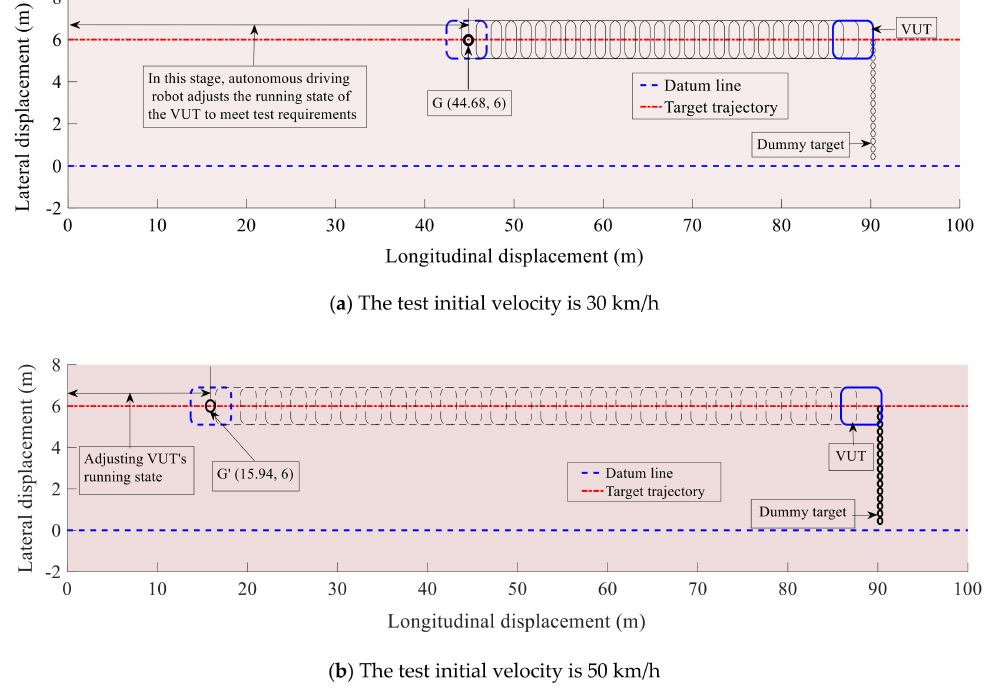
Figure 13. The demonstration process diagrams for the VUT and dummy